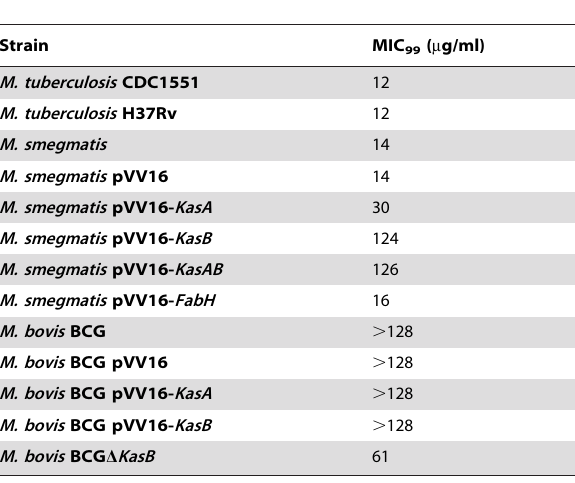
Table 1. Influence of Mt-KasA, Mt-KasB and Mt-FabH overexpression on platensimycin in whole cell inhibition of M. tuberculosis , M. smegmatis and M. bovis